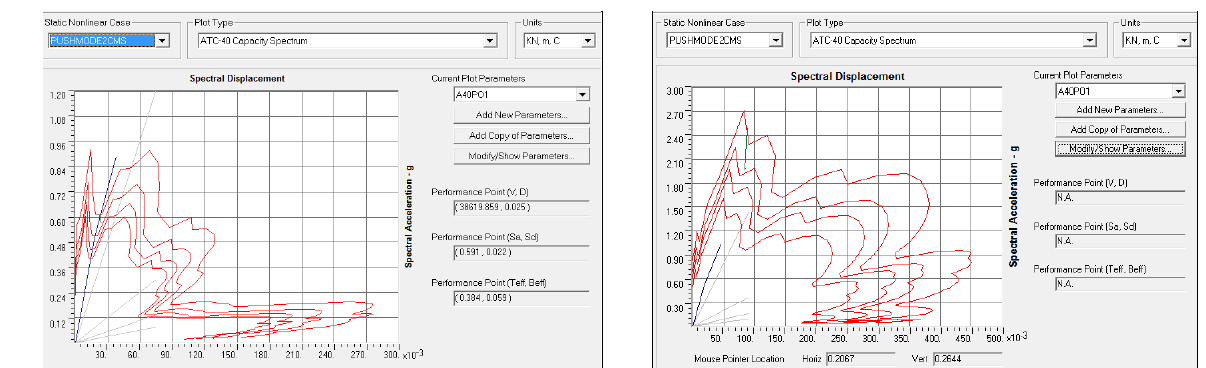
Fig. 13. Capacity spectrum in the transverse direction for El Centro earthquake